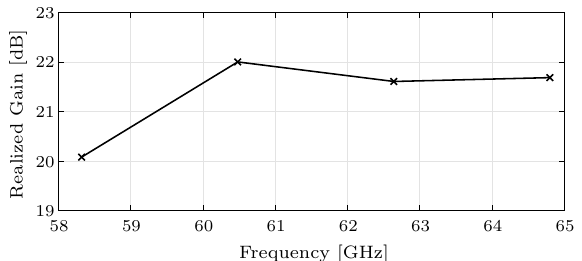
Fig. 11 Maximum realized gain for 2 × 16 antenna array simulated at center frequencies of 802.11ad channels 1–4